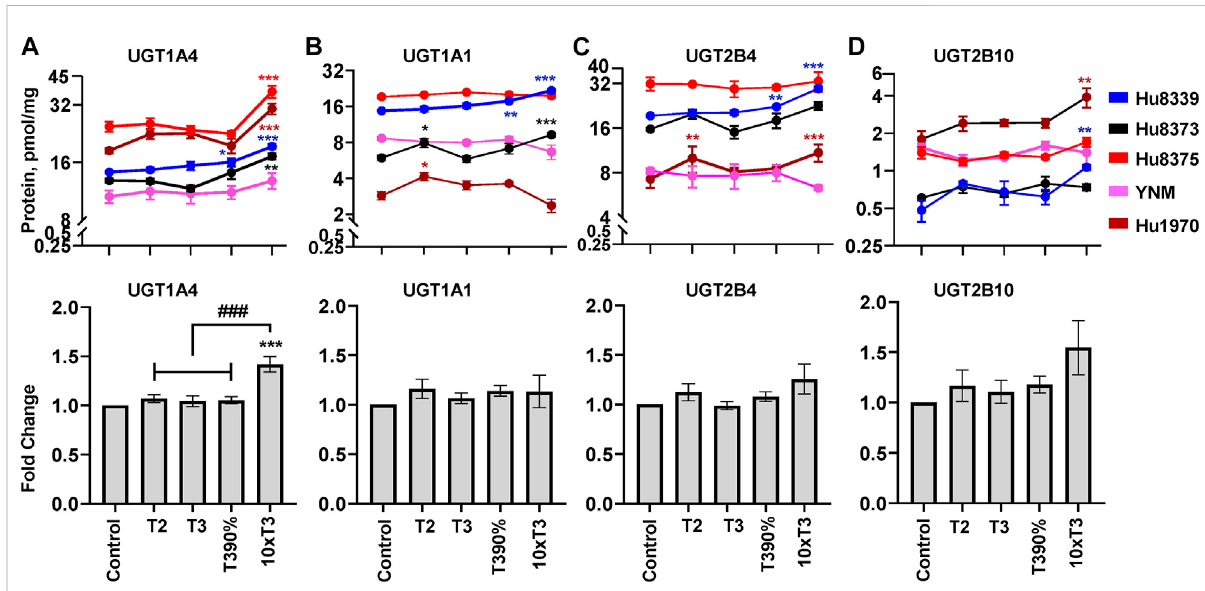
FIGURE 4 PRHs increased the absolute protein concentration of key UGT isoforms in SCHH. Human primary hepatocytes from quali fi ed donors were exposed to vehicle control or PRH cocktails. The PRH cocktails target average trimester 2 (T2), average trimester 3 (T3), upper range of T3 (T3-90%), and supraphysiological (10xT3) PRH concentrations (Table 1). The line graphs represent mean ± SEM absolute protein concentration of UGT1A4 (A) , UGT1A1 (B) , UGT2B4 (C) , and UGT2B10 (D) in SCHH in response to exposure to PRHs within each hepatocyte donor ( n = 3 – 4 biological replicates per group). The bar graphs below represent mean ± SEM fold-change for each UGT relative to control across all donors ( n = 5 per group). * p < 0.05, ** p < 0.01, *** p < 0.001 versus control. #Represents the concentration-dependent effect across PRH groups (### p <